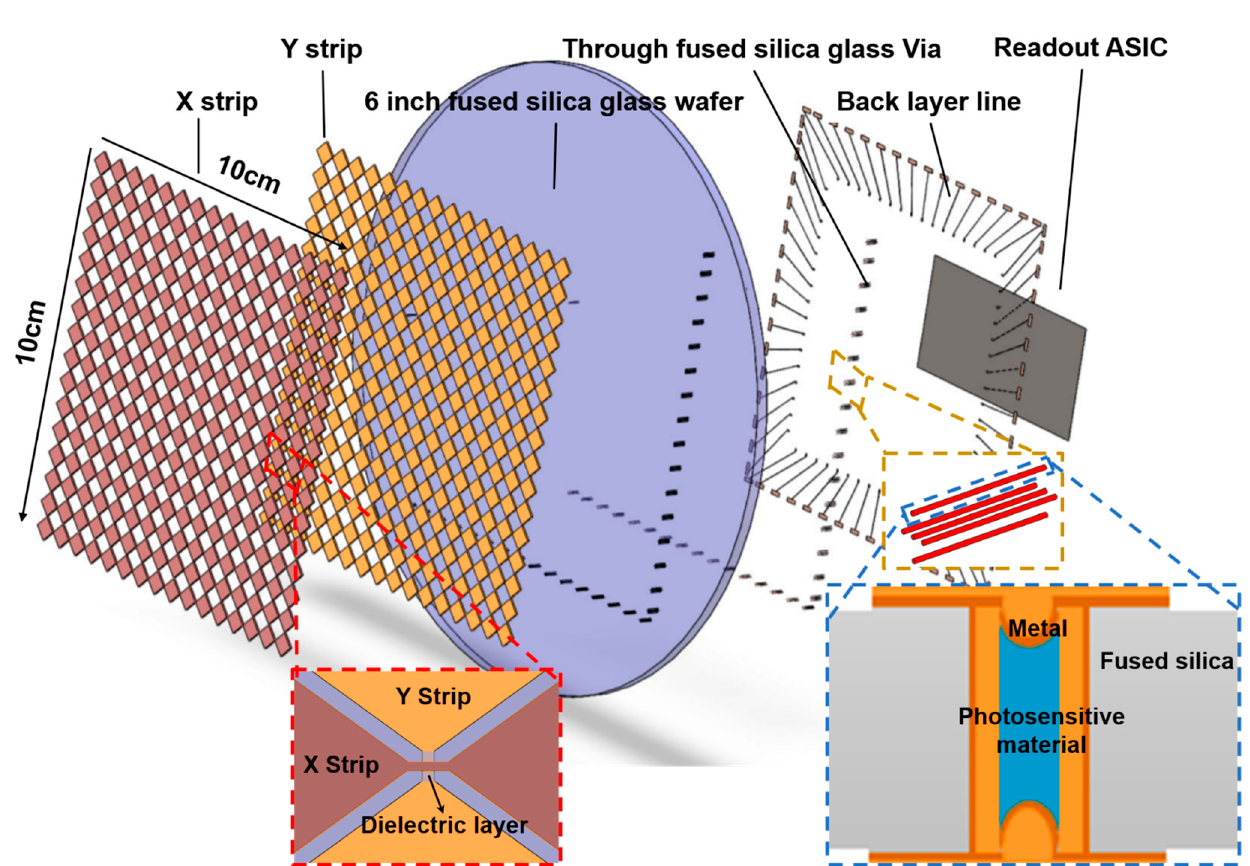
Figure 3. Schematic drawing of the prototype charge detector.